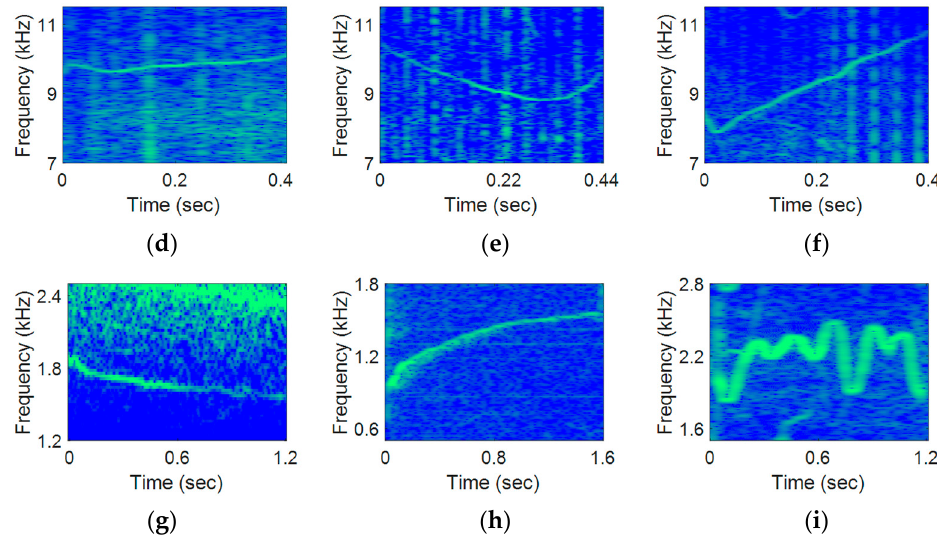
Figure 7. Mean Opinion Score (MOS) test whistle of white sided dolphin of ( a ) flat, ( b ) moderate variation, ( c ) dramatic variation; Delphinus delphis of ( d ) flat, ( e ) moderate variation, ( f ) dramatic variation; Killer whale of ( g ) flat, ( h ) moderate variation, and ( i ) dramatic variation.